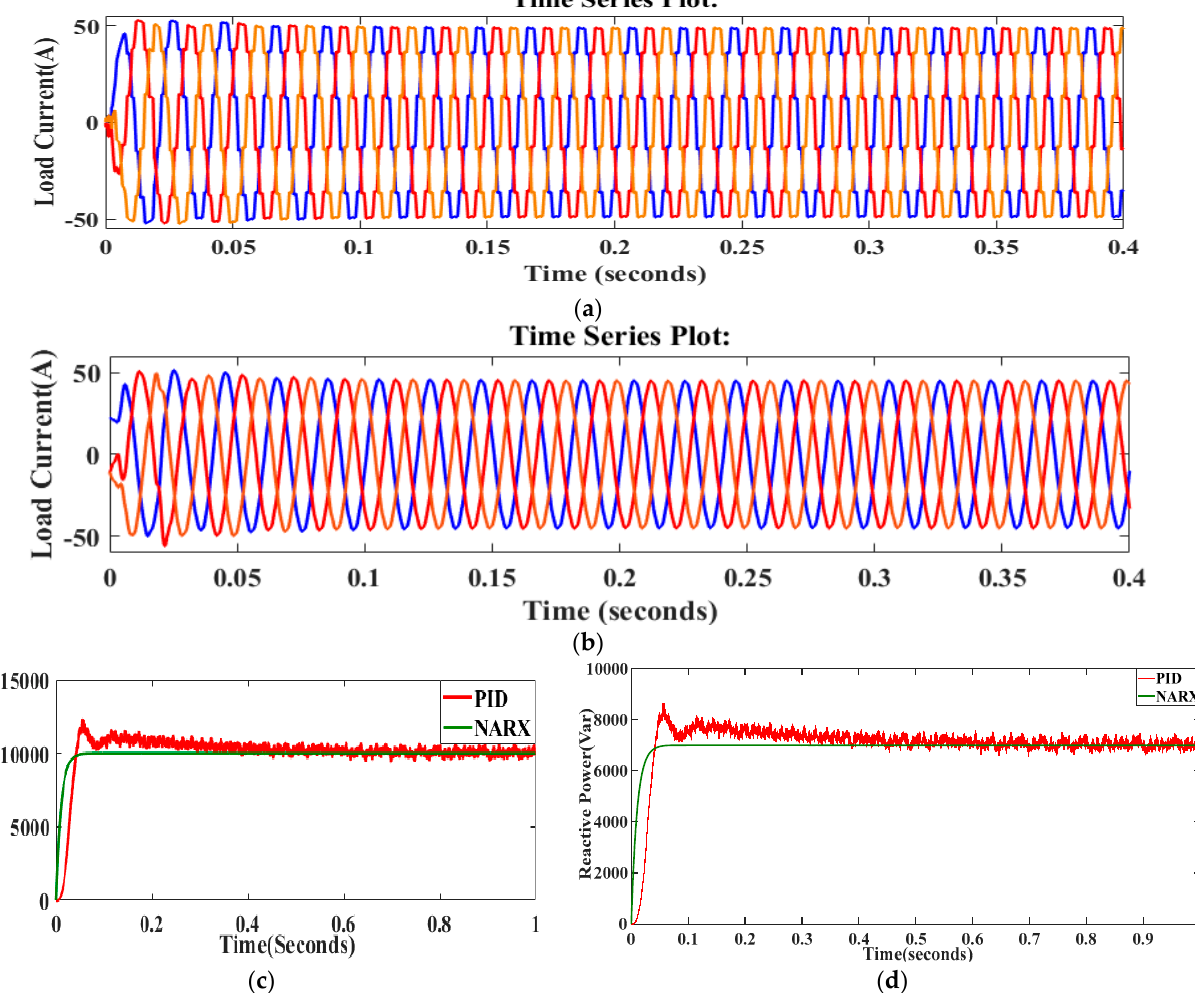
Figure 12. ( a ) Load current waveform with conventional PID. ( b ) Load current profile with pro- posed controller. ( c ) Relative load power variation: real power with PID and NARX controller. ( d ) Comparative load power profile: unreal power with PID and NARX controller. Table 6. PID, Fuzzy-PID, and NARX-NN controller comparison.